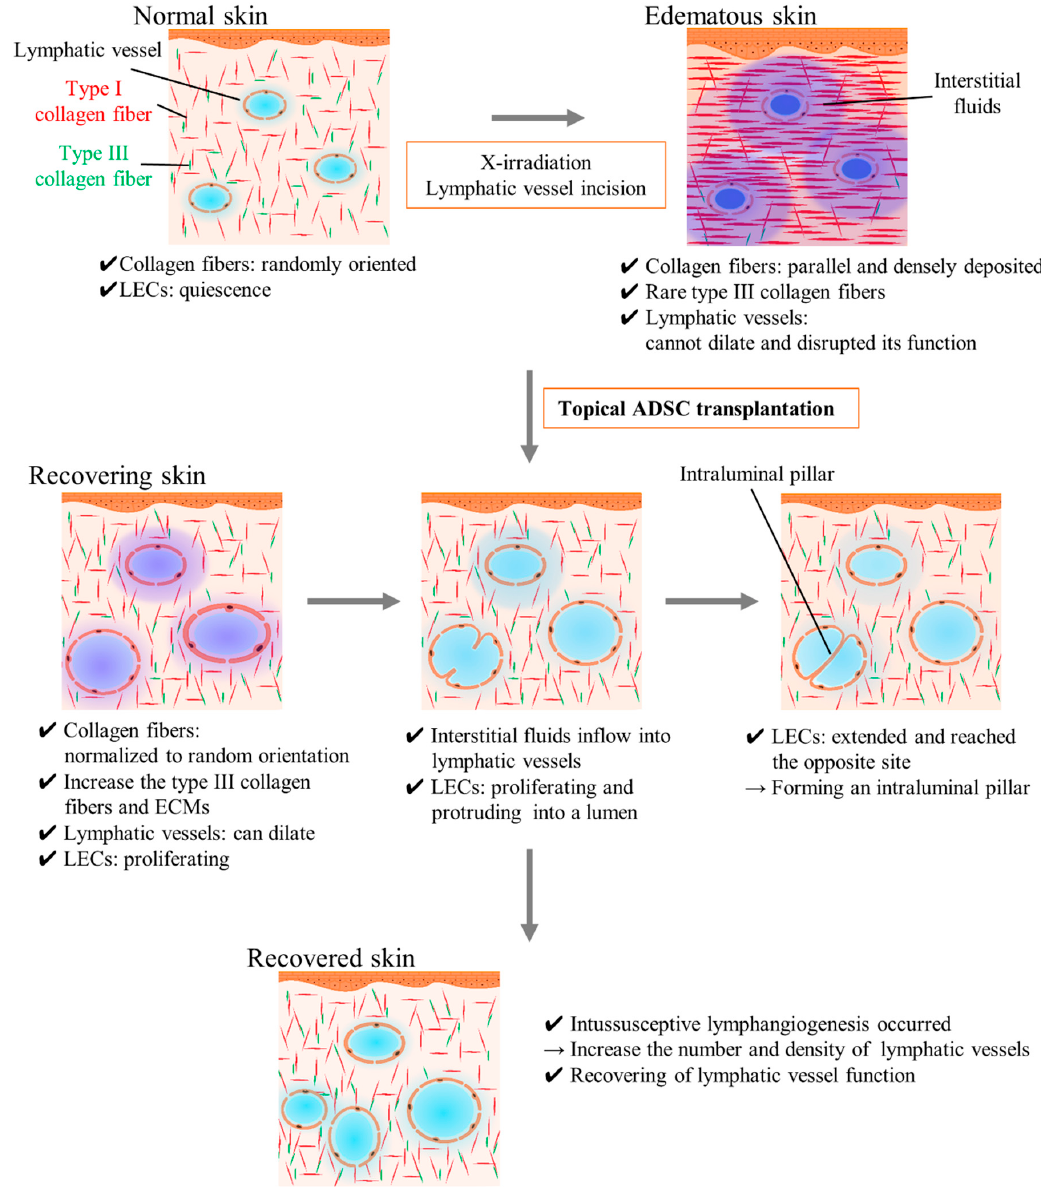
Figure 7. Schematic images of adipose-derived stem cells (ADSC) transplantation effects and intussusceptive lymphangiogenesis. In normal skin, type I collagen fibers are randomly oriented and contribute to appropriate interstitial tissue function. In edematous and recovering skin, type I collagen fibers are parallel deposited and interstitial tissue function is disrupted (e.g., lymphatic vessels cannot dilate and absorb the excessive fluids in the legion). ADSC transplantation improves the fibrosis by recovering the collagen fibers orientation and increasing the number of lymphatic vessels by promoting LEC proliferation and intussusceptive lymphangiogenesis. ADSC, adipose-derived stem cell; ECM, extracellular matrix; LEC, lymphatic endothelial cell.